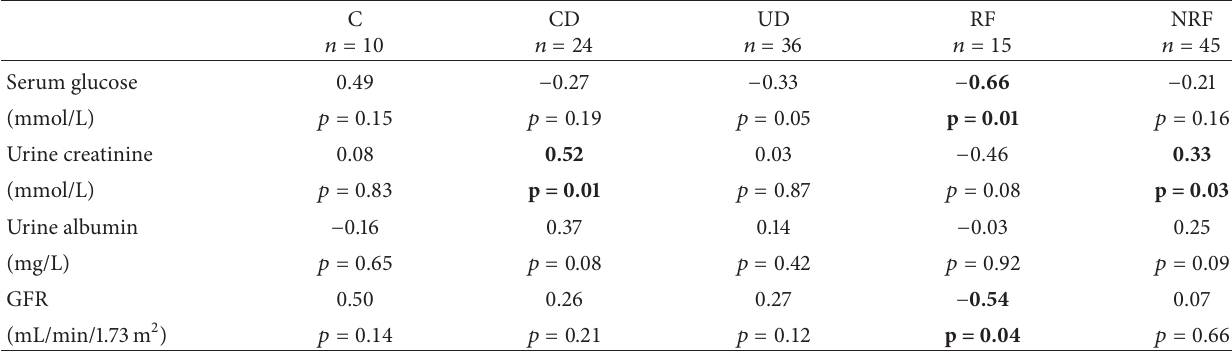
Table 3: Results of Spearman’s rho test for correlations between EVs density and biochemical